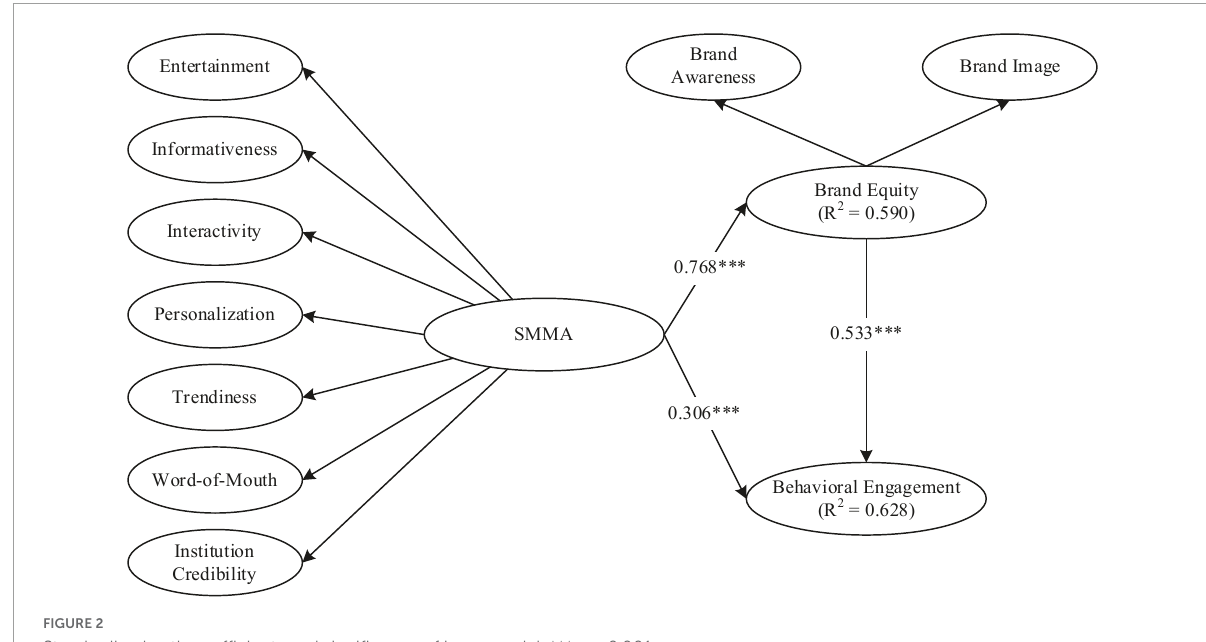
FIGURE2 Standardized path coefficients and significance of inner model. ∗∗∗ p < 0.001.